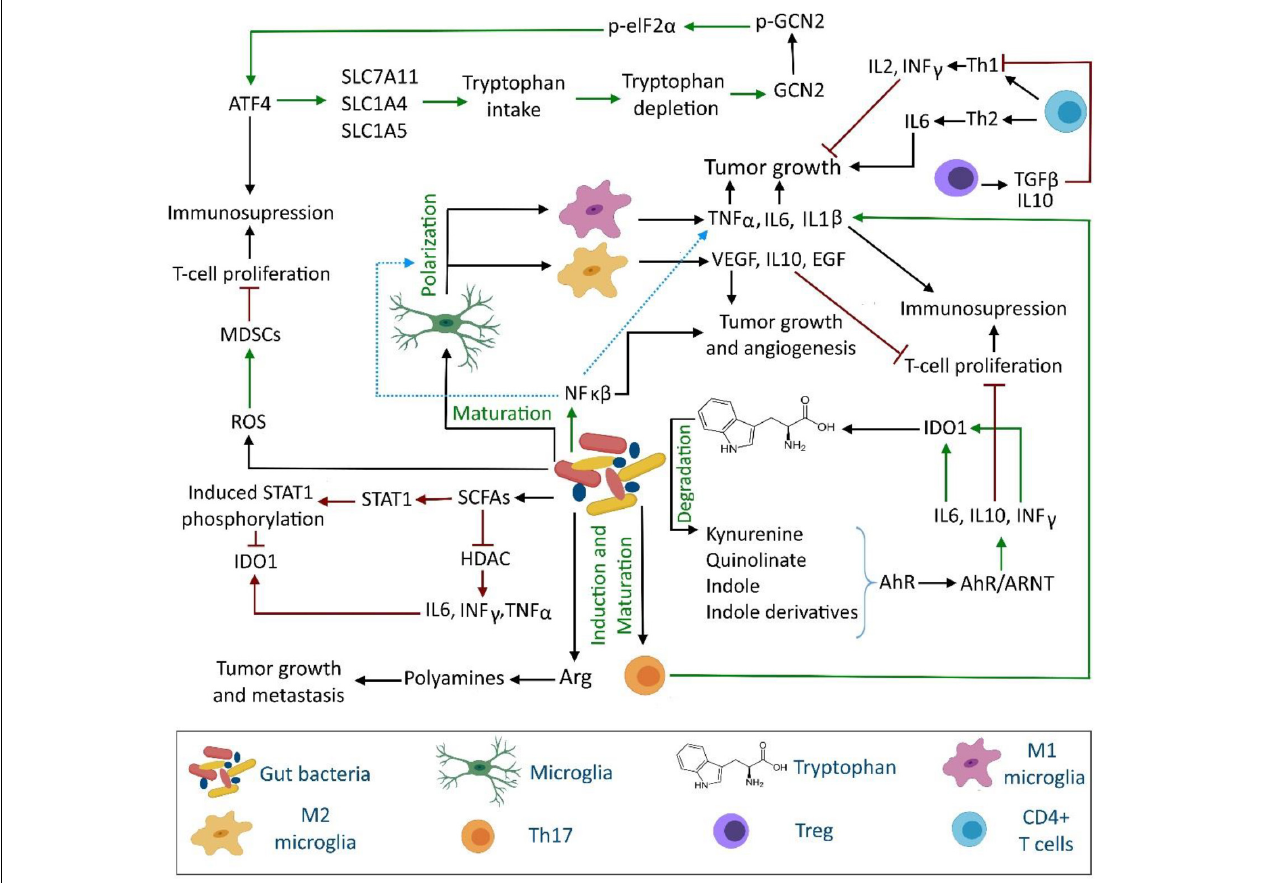
FIGURE 1 | Interaction between gut microbiota, immune system and tryptophan metabolism in brain tumor development. The gut microbiota can influence the brain tumor cells proliferation and metastasis through direct and indirect regulation of tryptophan and arginine metabolism, inflammatory cytokine production, release of short chain fatty acids, aryl hydrocarbon receptor modulation, microglia maturation, and T cell proliferation. AhR, aryl hydrocarbon receptor; Arg, arginine; ARNT, AhR nuclear translocator; ATF4, activating transcription factor 4; eIF2 α , eukaryotic initiation factor 2 α (eIF2 α ); GCN2, general control nonderepressible-2; HDAC, histone deacetylase; MDSCs, myeloid-derived suppressor cells; ROS, reactive oxygen species; SCFAs, short chain fatty acids; STAT, signal transducer and activator of